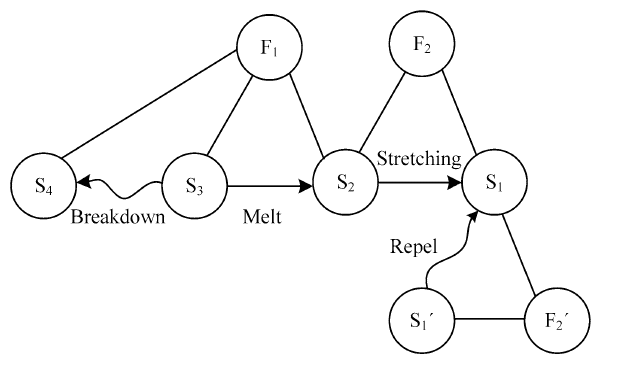
Figure 2. Material-field model of